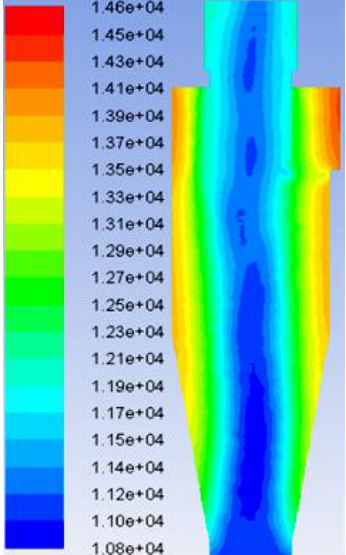
Figure 4. 3D map contours of static pressure (Pa) at PE100 with 14040 m 3 hr -1 N2 flow rate.